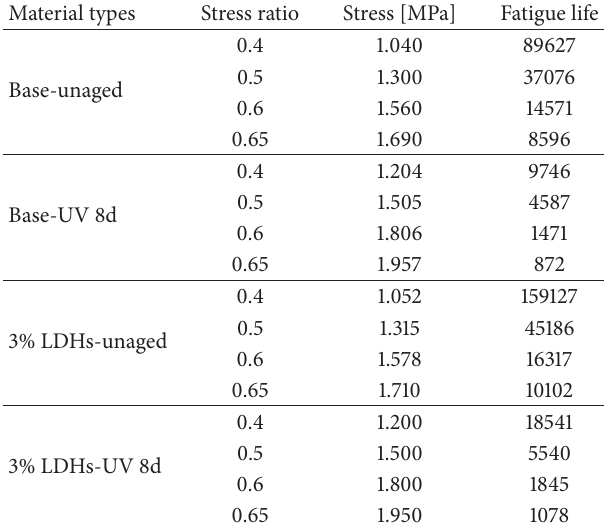
Figure 8: Indirect tensile modulus of mixture specimens under different stress level at 5 ∘ C. Table 5: Indirect tensile fatigue life of asphalt mixture specimens at 5 ∘ C.